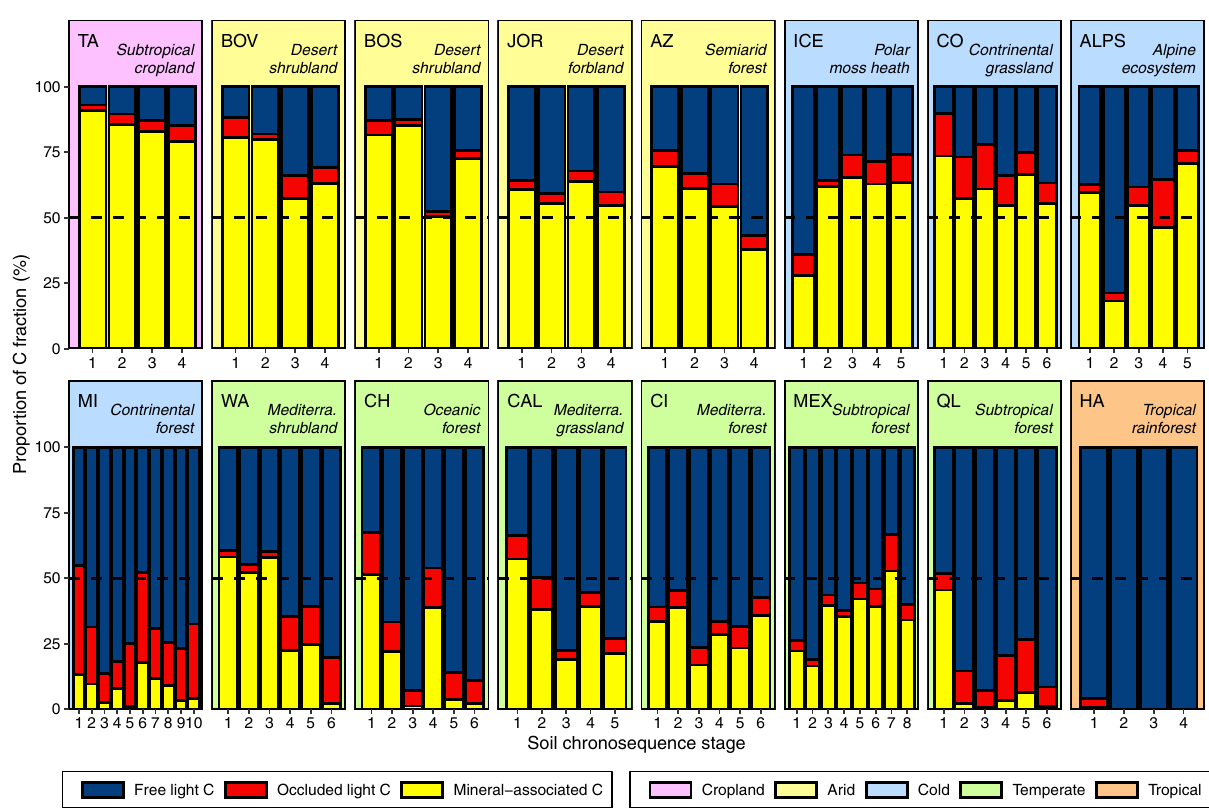
Fig. 1 Proportion of carbon fractions in surface soil organic matter during ecosystem development. Changes in the relative abundance of free light, occluded light and mineral-associated carbon (C) fractions in surface soil organic matter during ecosystem development across 87 sites from 16 globally distributed soil chronosequences. Dashed line indicates 50%. Proportion of C fraction i (%) was calculated as C fraction i content × 100/sum of all C fraction contents. The soil chronosequences are ordered by major biomes: croplands, arid, continental (cold), temperate and tropical ecosystems according to the Koppen classi fi cation 38 . Additional statistical analyses and alternative representation of these data can be found in Supplementary Figs. 3 and 4. See text and Supplementary Data 1 for more information on the